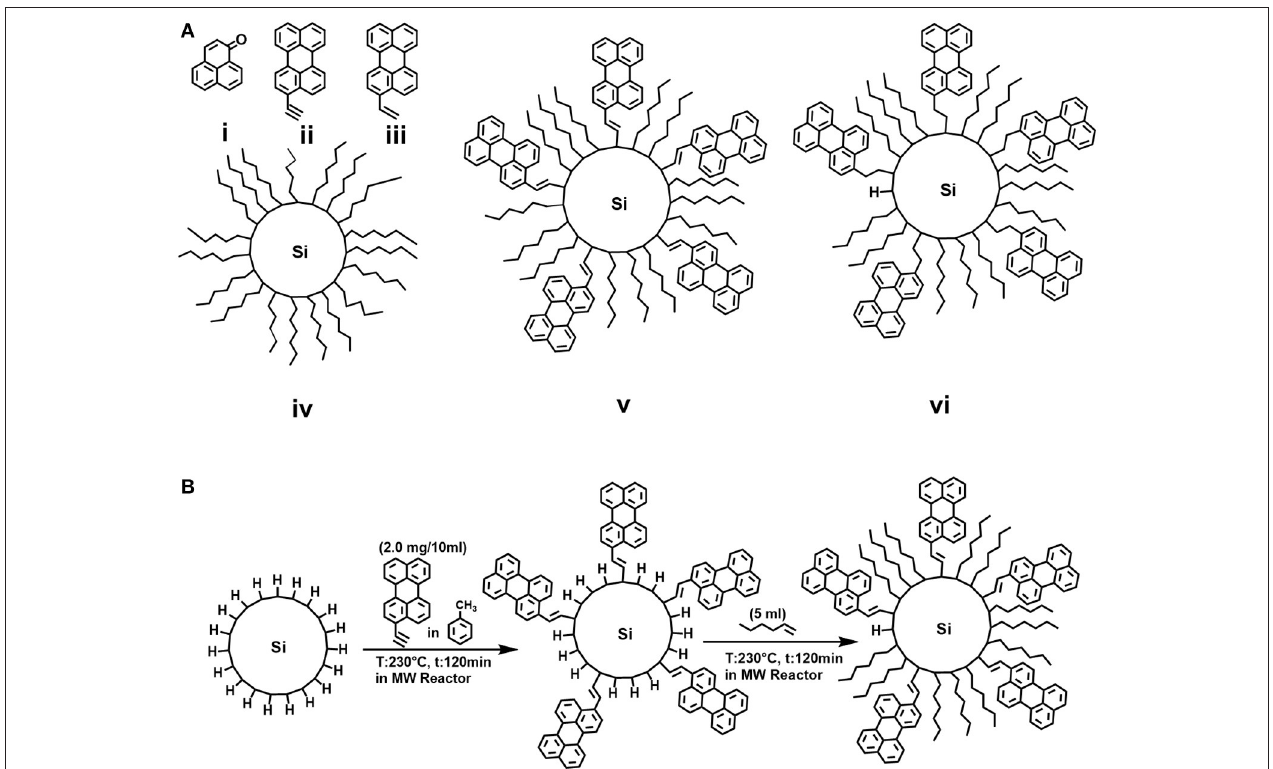
FIGURE 1 | (A) Molecular structures of (i) phenalenone ( phe ), (ii) 3-ethynylperylene ( dye-1 ), (iii) 3-ethenylperylene ( dye-2 ), (iv) hexyl-functionalized SiNCs ( C6-SiNCs ), (v) 3-ethynylperylene/hexyl-functionalized SiNCs ( C6-1-SiNCs ) and (vi) 3-ethenylperylene/hexyl-functionalized SiNCs ( C6-2-SiNCs ); (B) Schematic representation of the hydrosilylation reaction of hydrogen-terminated SiNCs with dye and